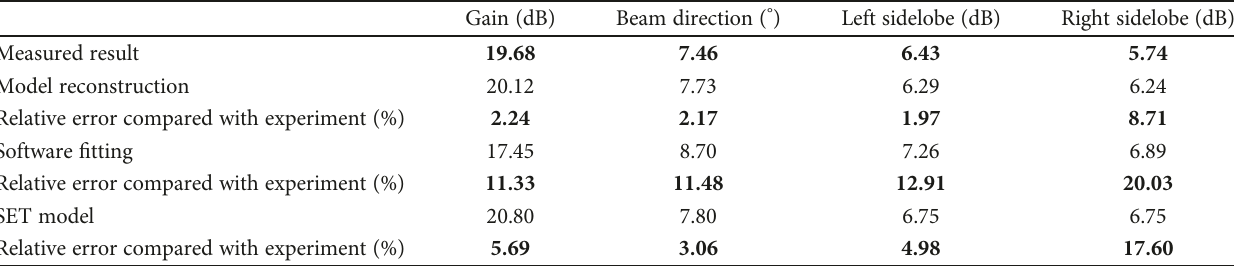
Table 3: Comparison between solution results using di ff erent methods.